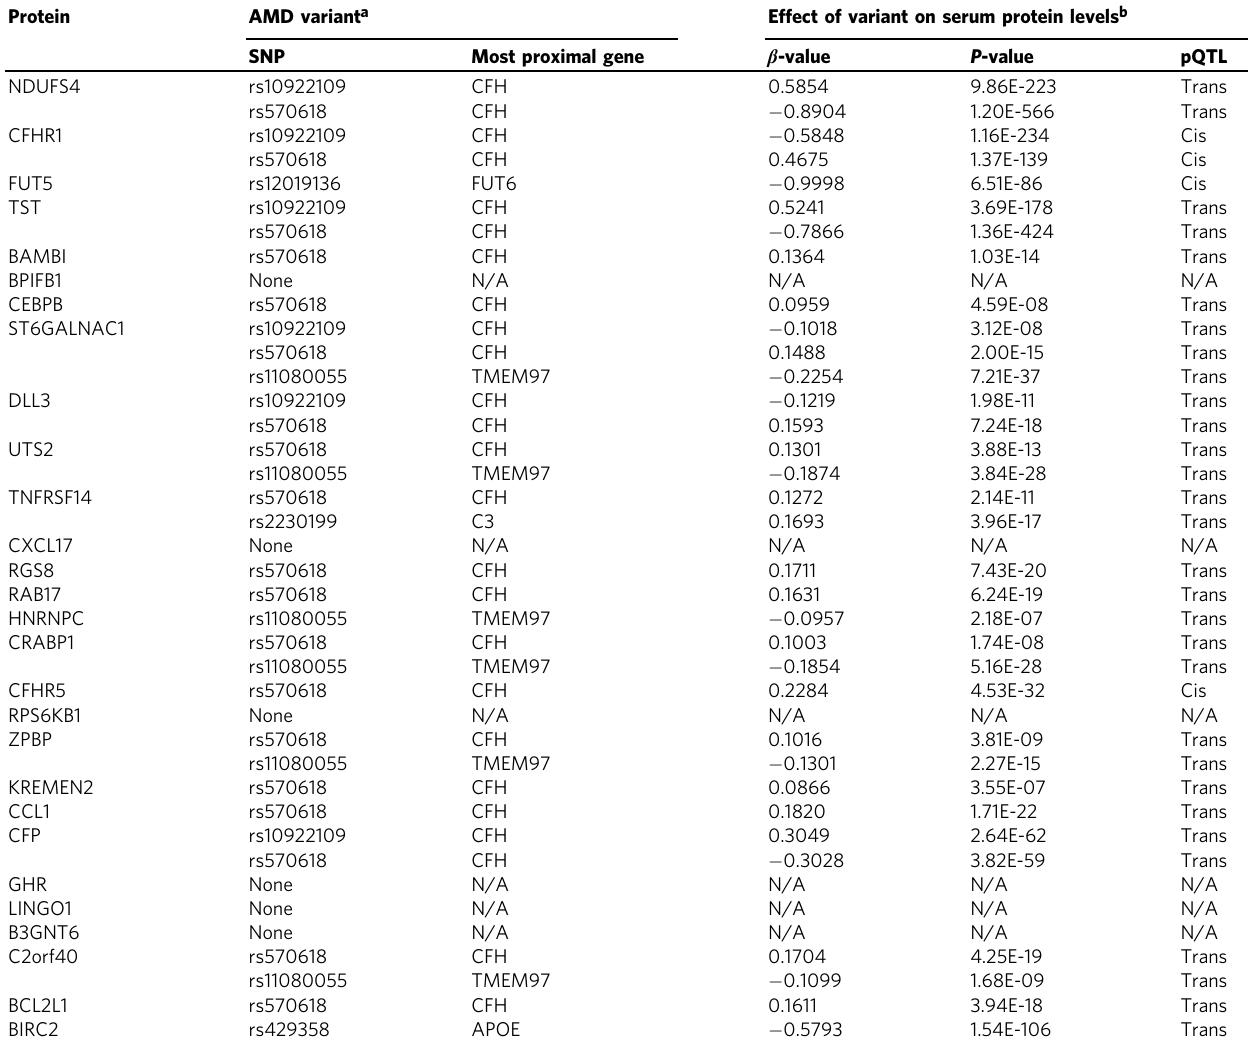
Table 2 AMD-linked proteins associated with AMD genetic risk variants using linear regression. Protein AMD variant